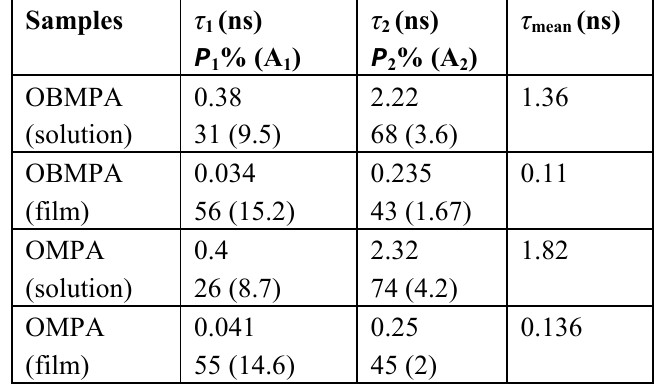
Table 2. Decay constant times ( τ percentage contributions P